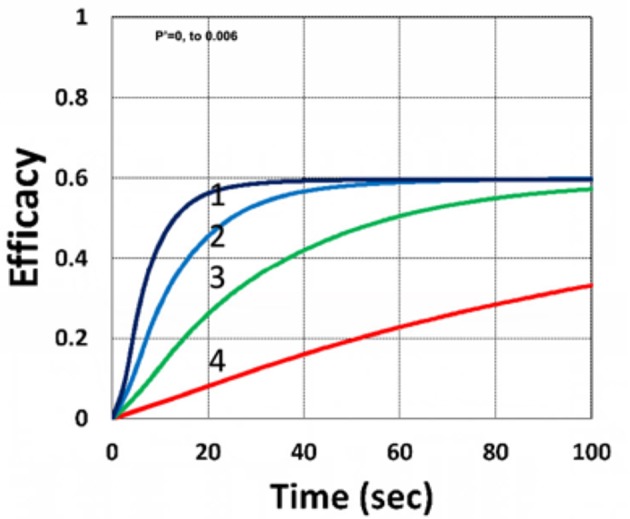
Dynamic profiles. Same as Figure 9, but for P′ = (0, 0.0001, 0.001, 0.006), for curves (1, 2, 3, 4); for b = 0.02, I0 = 5 mW/cm2 and C0 = 0.01 mM.